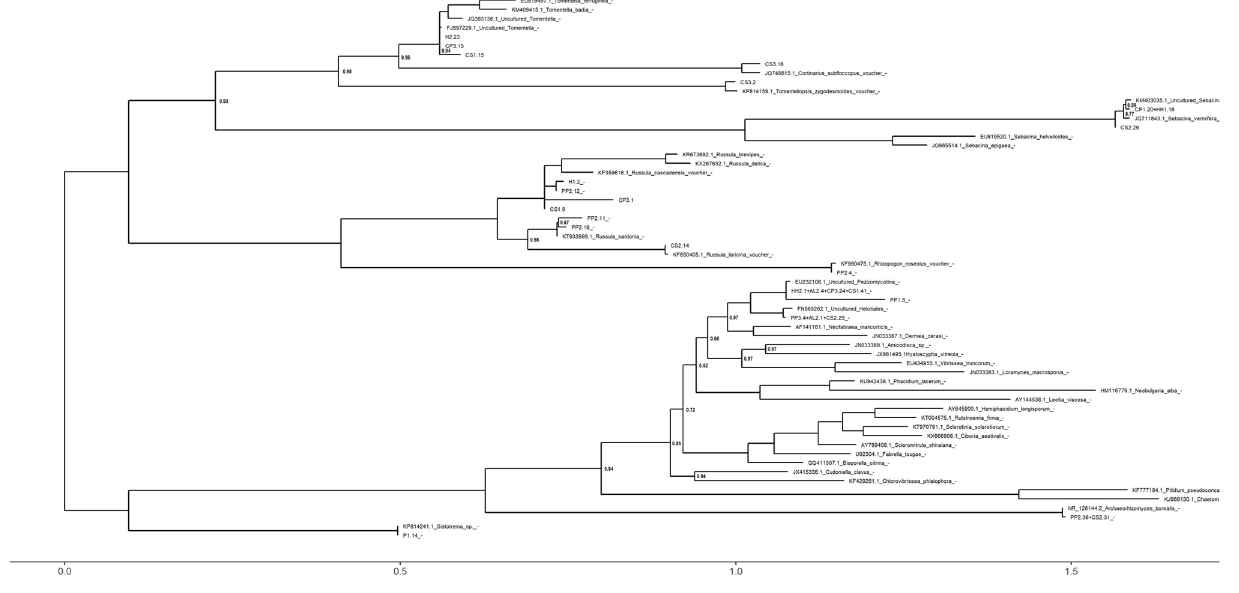
Figure 1. Maximum likelihood tree based on ITS sequences obtained from field-collected ECM root tips and reference sequences obtained from Genbank (included with their accession numbers). Sequences obtained in this study are named in Table 1. Sequences with similarity > 99% are grouped and listed together. Numbers at the nodes are values for branch support estimated using the bootstrap likelihood ratio test (1000 resamplings, values 0–1, values above 0.98 are not displayed for easier viewing). The scale bar indicates the evolutionary distances.